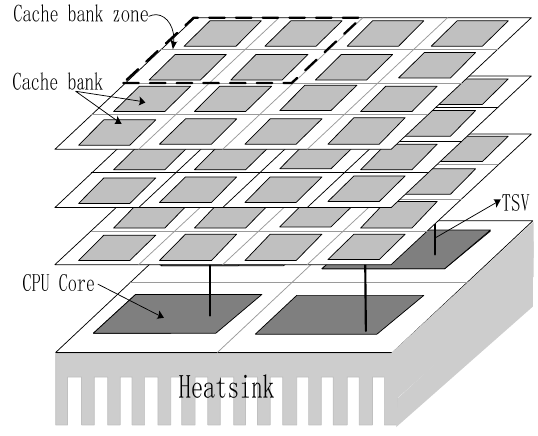
Figure 1. Die floorplan of 3D-stacked non-uniform cache architecture (NUCA) cache architecture.